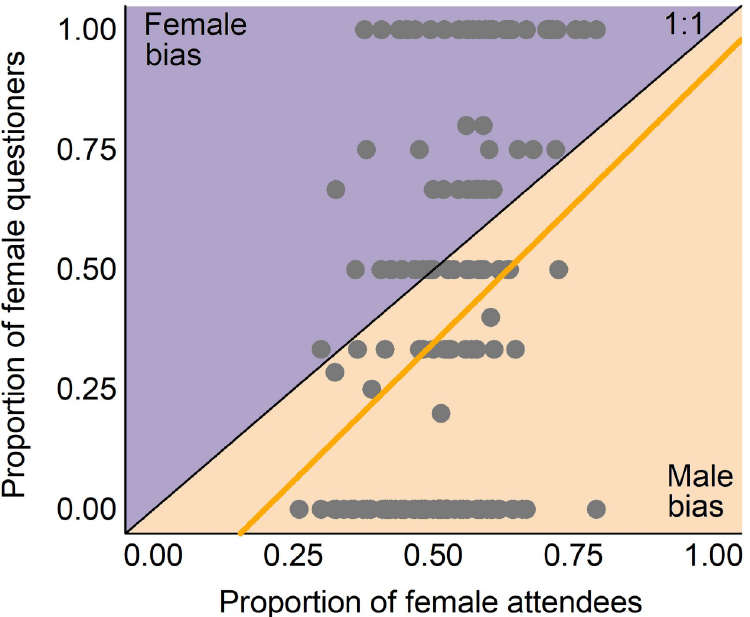
Fig 3. Proportion of questions asked by women plotted against the proportion of women attendees during the analyzed Q&A sessions. The black line shows the theoretical proportional relationship between the two parameters. The yellow line shows the real proportional relationship based on a linear regression of the data (mean odds ratio: 0.7).